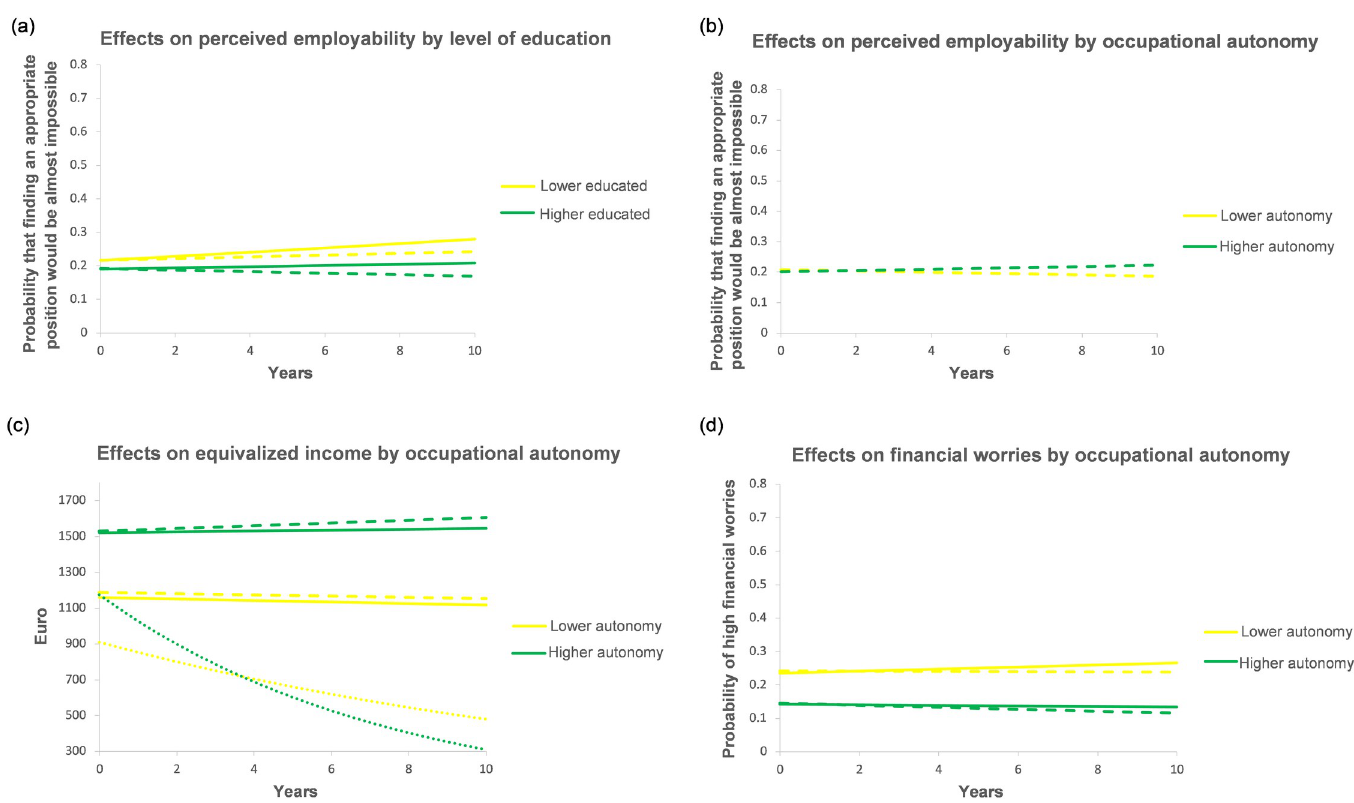
Fig 5. Moderation of the within-level effects of employment status duration by person-specific mean SES across observations. Dashed lines = effects of employment duration. Solid lines = effects of organizational tenure. Dotted lines = effects of unemployment duration.